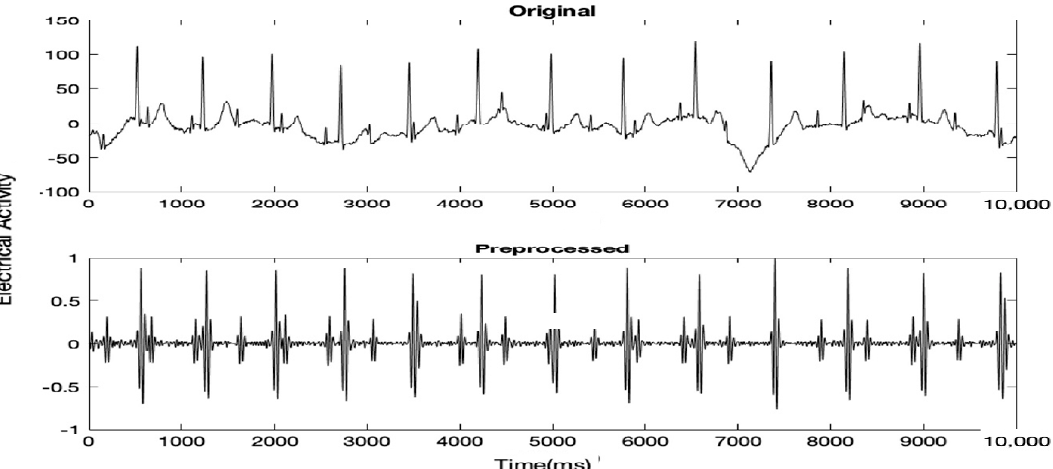
Figure 1. 5 s of a certain MAECG record before and after